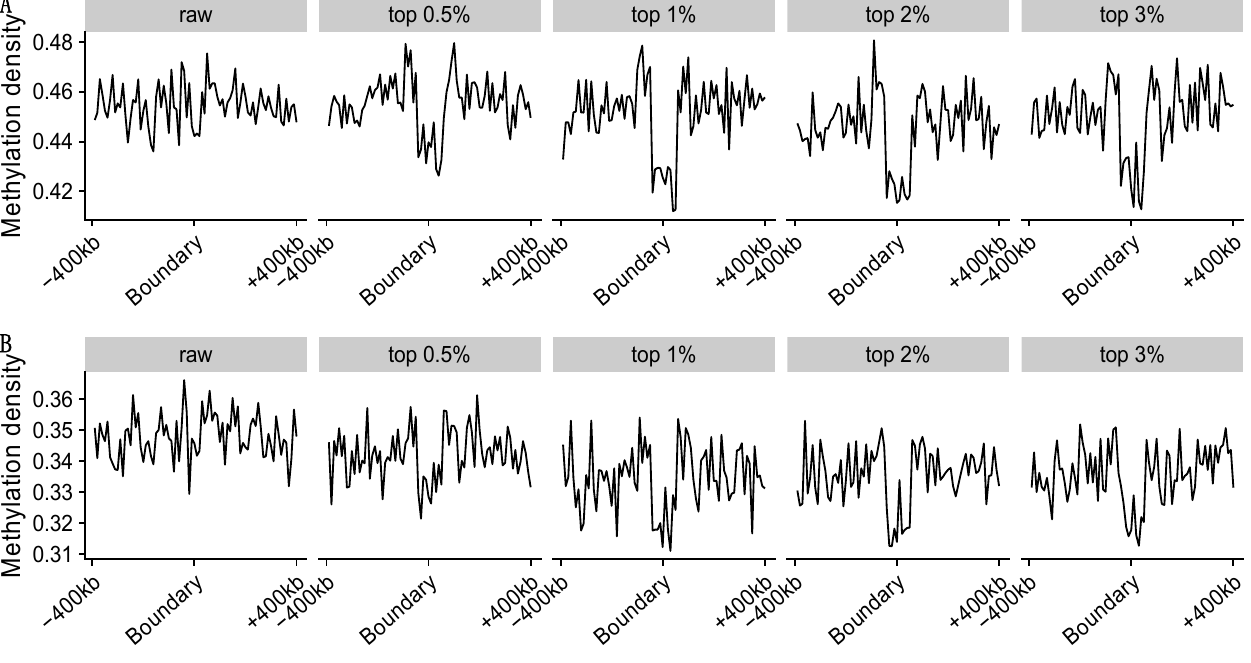
Figure 9. Methylation is depleted around TAD boundaries on data set 3 at 50 kb resolution for two single cells ( A ) and ( B ). TADs are called on raw and imputed (four different top parameters) single-cell Hi-C.